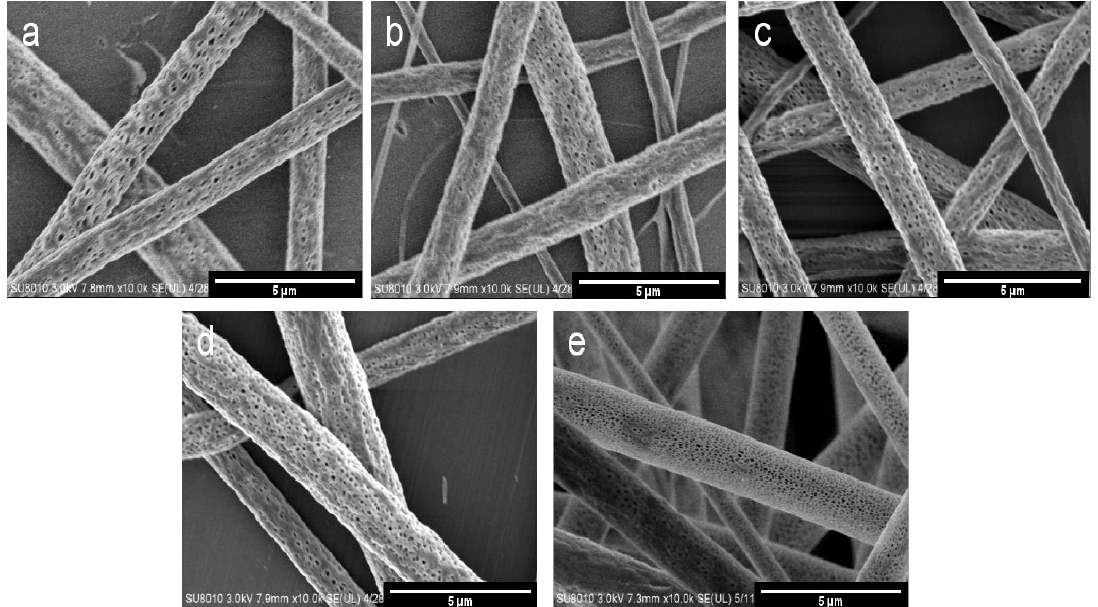
Figure 1. SEM (scanning electron microscope) images of different PLA porous fibers prepared using different needle diameters: ( a ) 14 G, ( b ) 16 G, ( c ) 18 G, ( d ) 19 G and ( e ) 21 G. (All images are ×10.0 k).